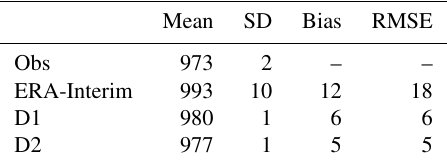
Table 4. Statistics for mean sea-level pressure from ERA-Interim reanalysis at 06:00UTC, 26 December 1999, 12h forecast using the D1 and D2 at 18:00UTC, 25 December 1999, versus observations at 06:00UTC, 26 December 1999. Mean (hPa), standard deviation (SD) error (hPa), bias (hPa), root mean square error (RMSE; hPa). Calculations are done for the nearest point. Small domain corre- sponds to 48–50 ◦ N, 2–4 ◦ E and includes 12 pairs of data and model